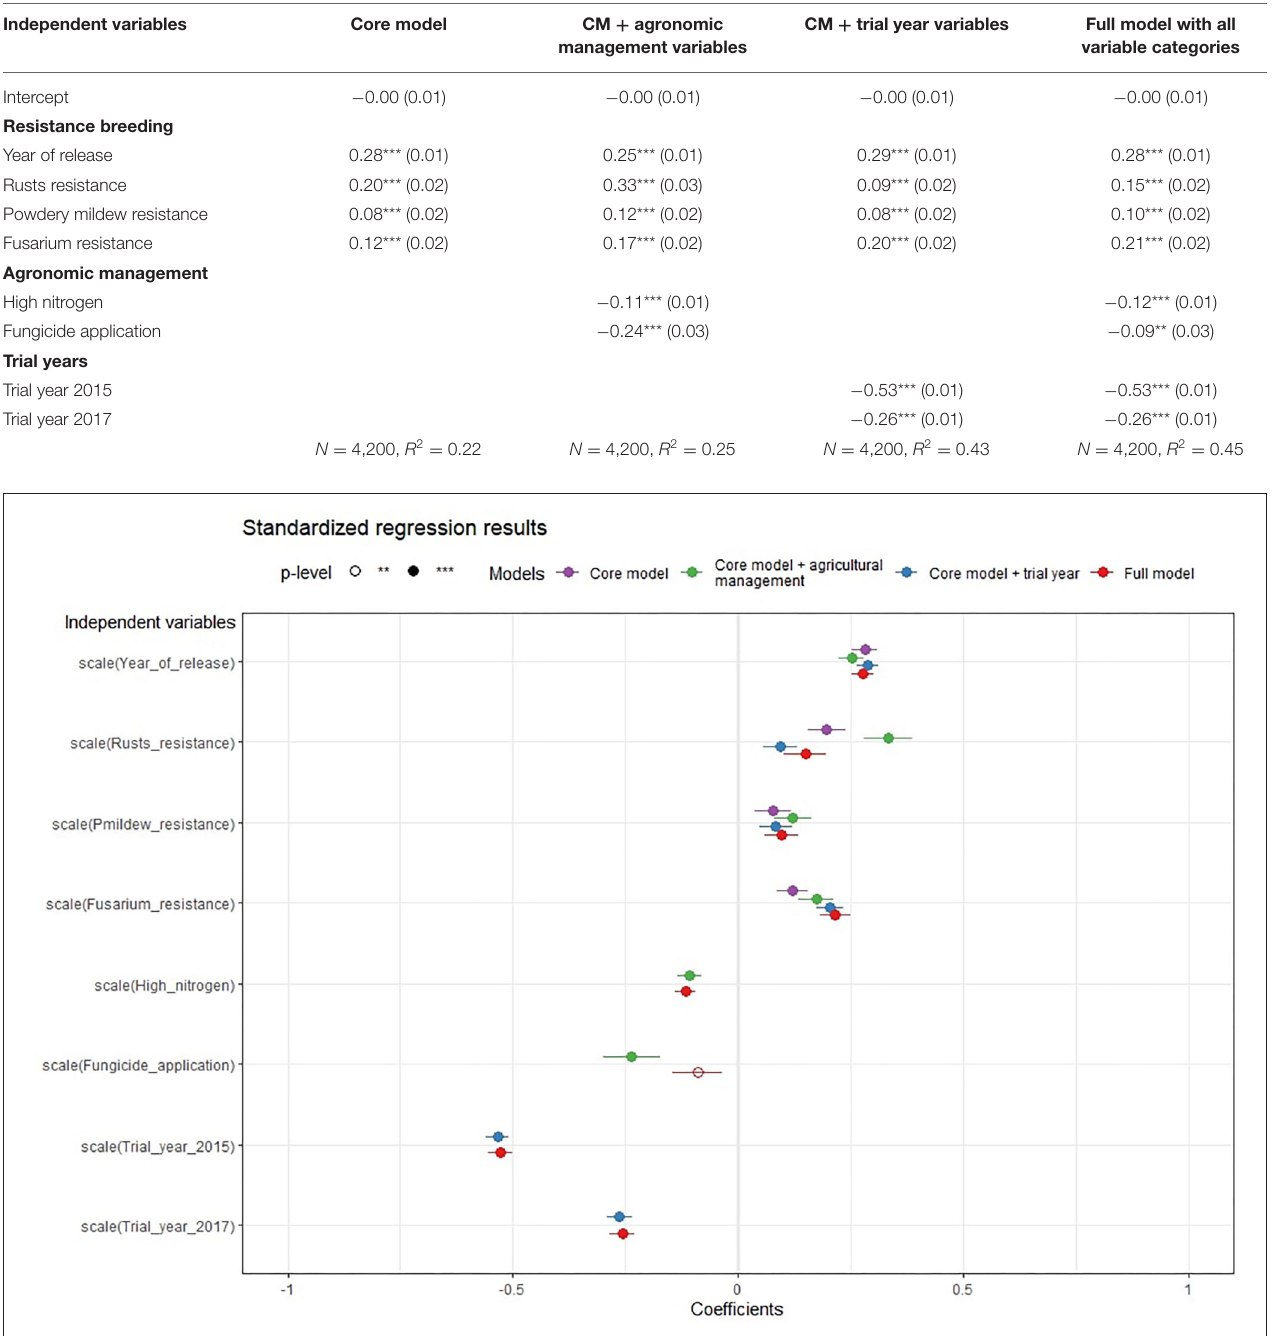
TABLE 4 | Standardized coefficients (standard errors) of the regression models with scaled variables and gross margin as the dependent variable (significance codes: *** p < 0.001, ** p < 0.01). Independent variables